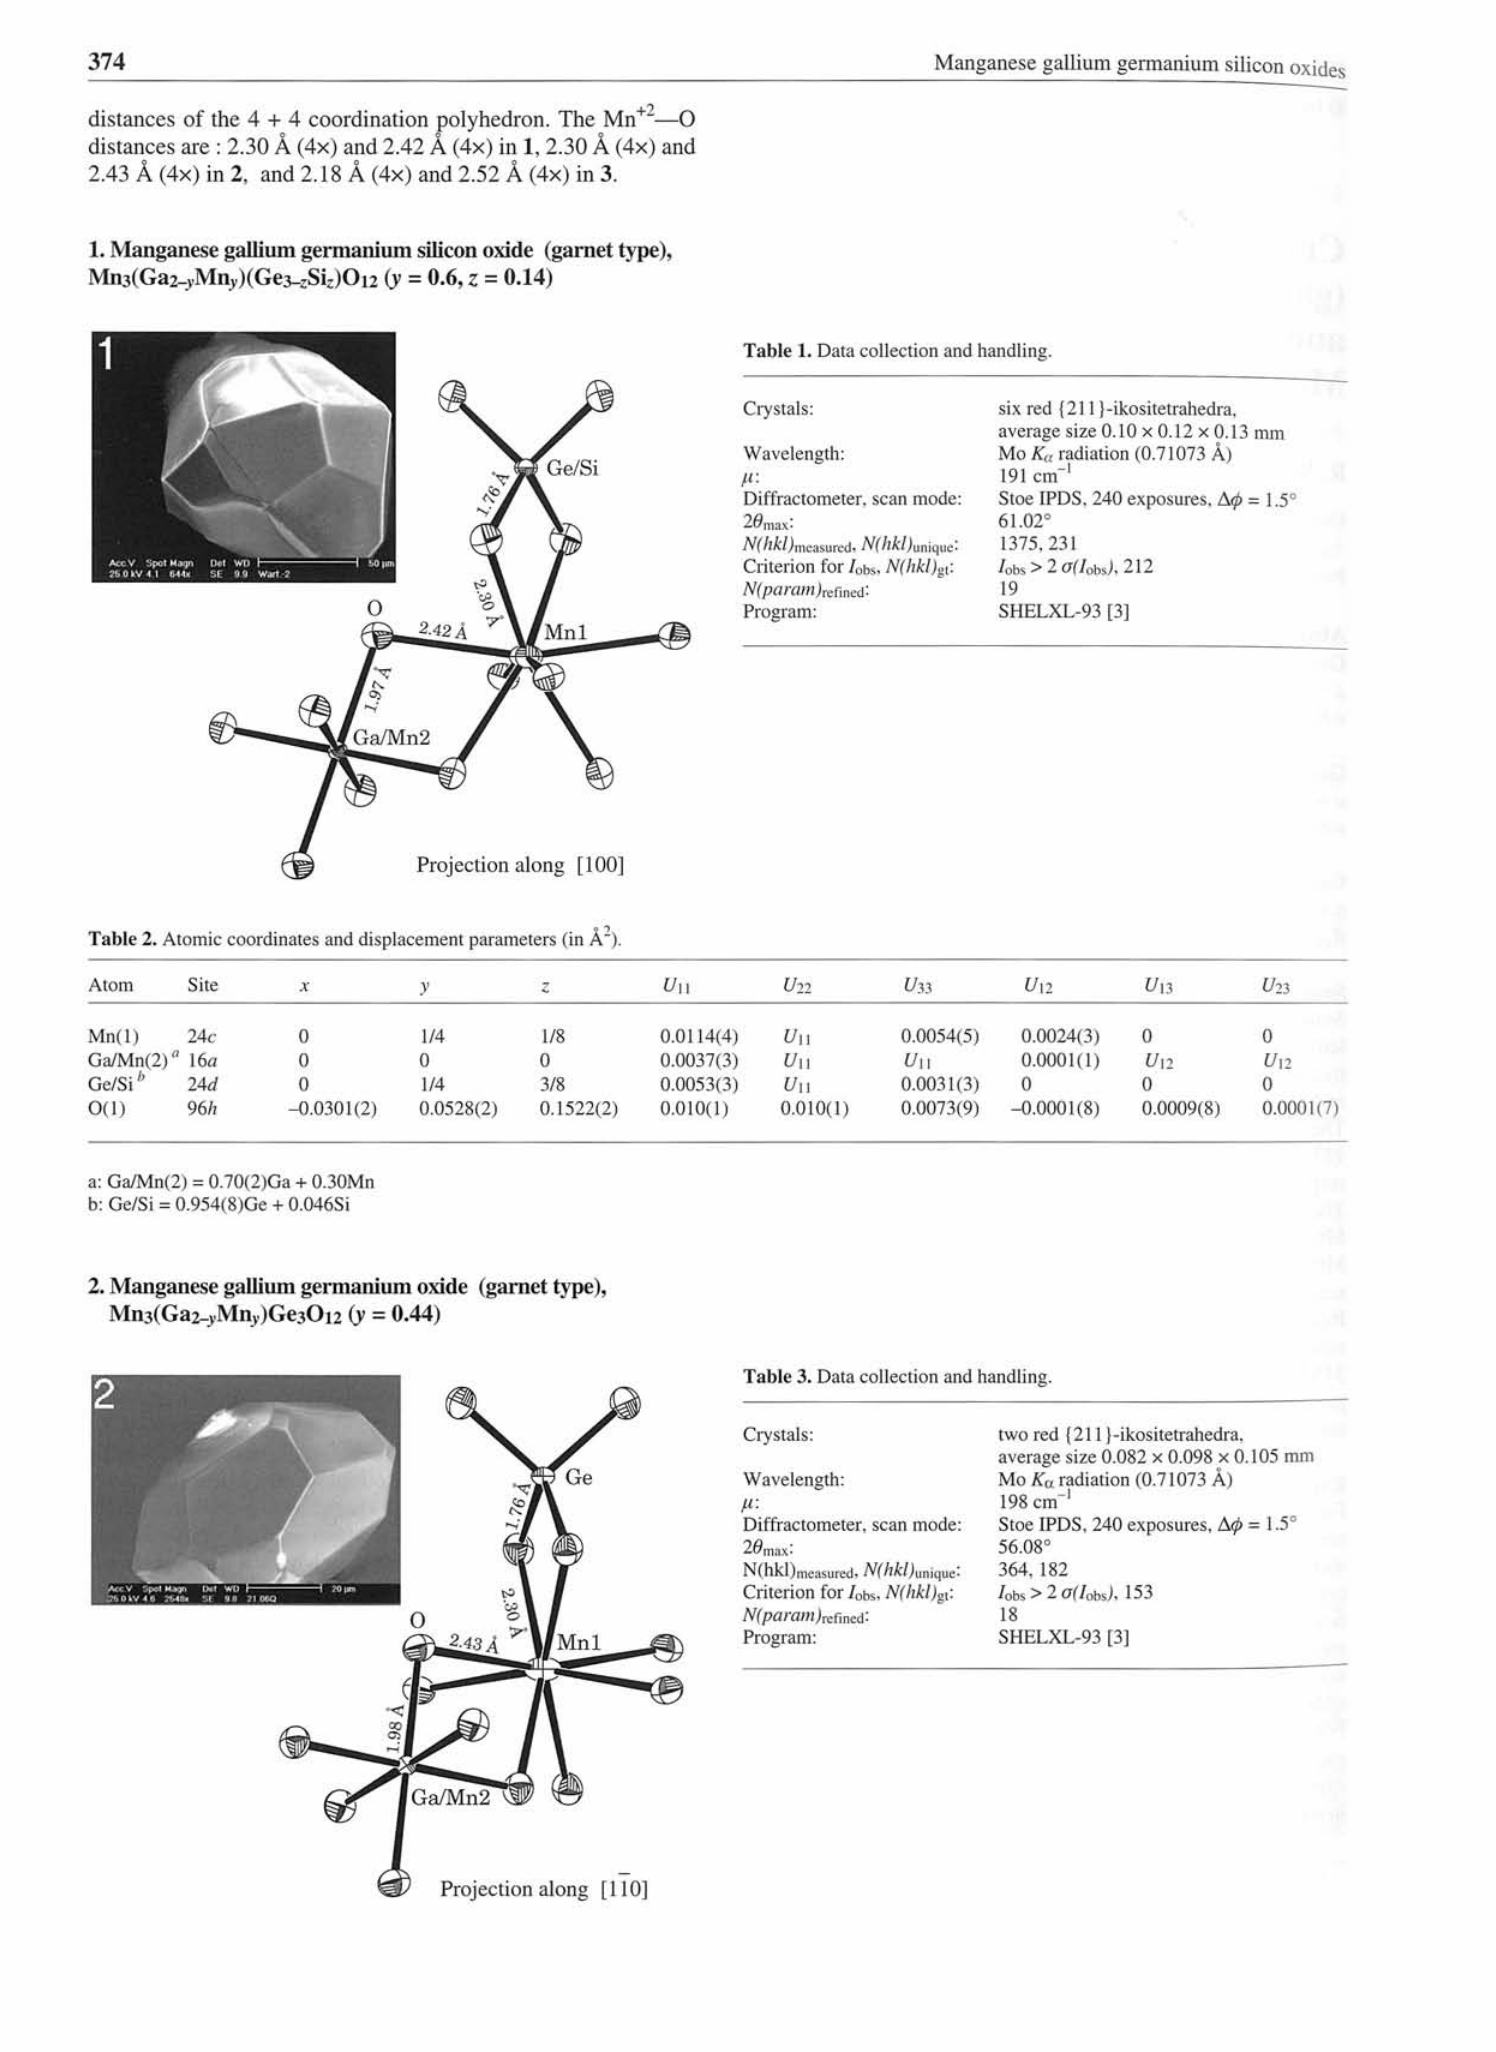
Table 3. Data collection and